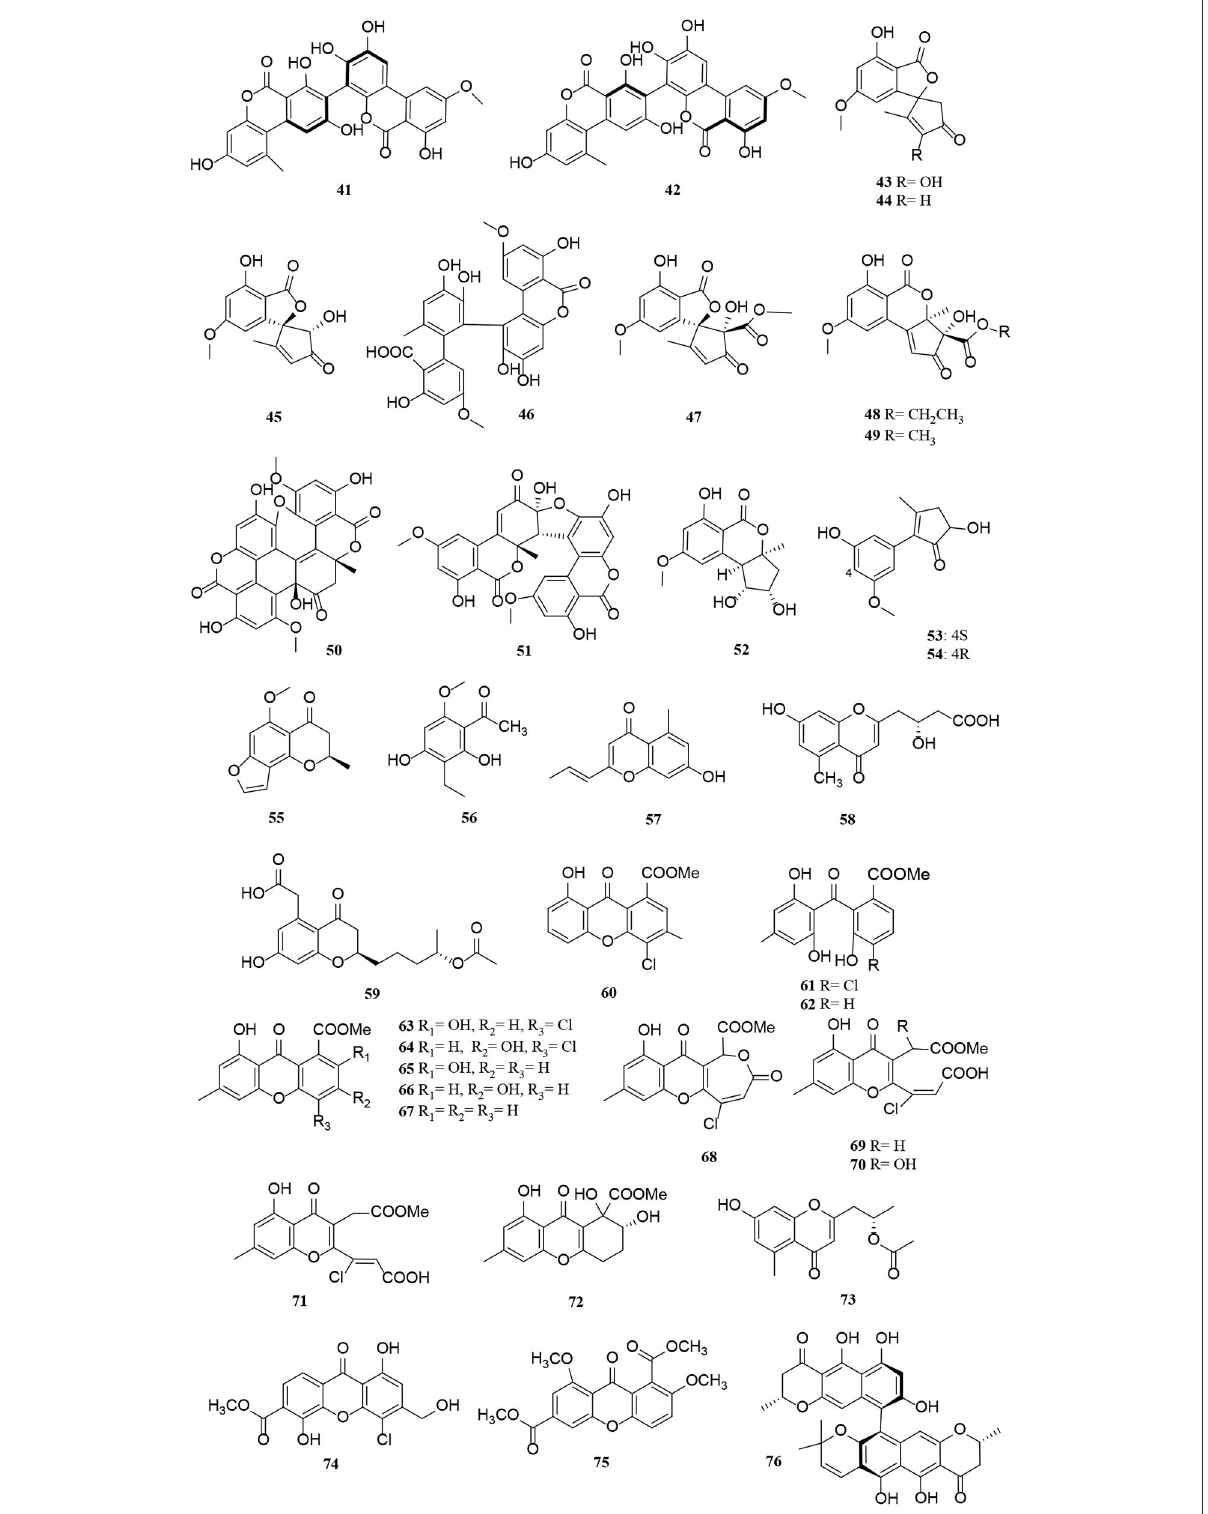
FIGURE4 Pyranone derivatives ( 41 – 76 ) from Alternaria